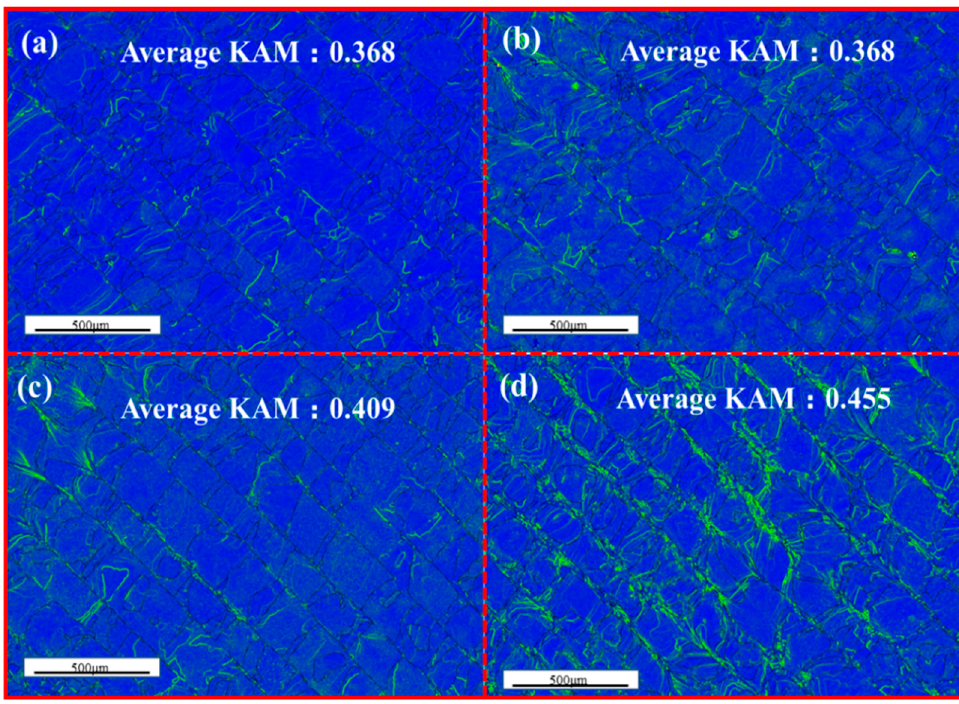
Figure 7. Kernel average misorientation (KAM) maps of the Ti-22Al-25Nb samples: ( a ) sample 1, ( b ) sample 2, ( c ) sample 3, and ( d ) sample 4.